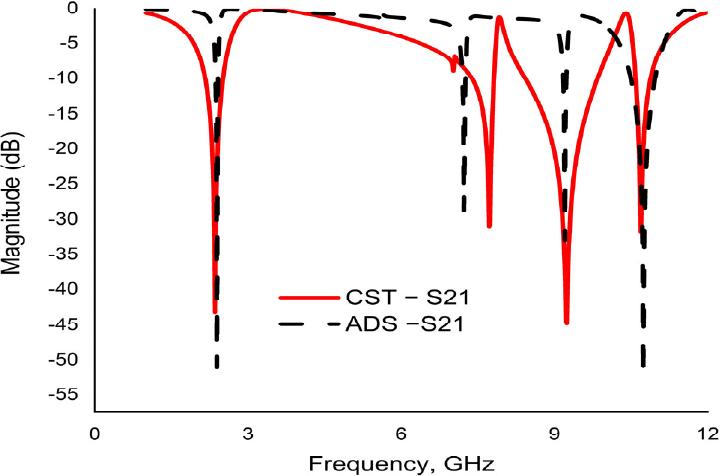
Figure 12. The transmission coefficient ( 𝑆 (cid:2870)(cid:2869) ) of the proposed unit cell simulated by CST and ADS software.